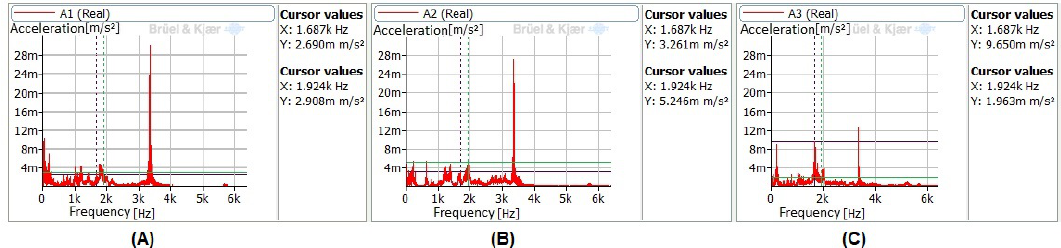
Figure 8. Signals showing natural frequencies of the workpiece being burnished at 900 mm/min, 400 N, 3 passes, and vibrations ON. ( A ) Accelerometer A1; ( B ) Accelerometer A2; ( C ) Accelerometer